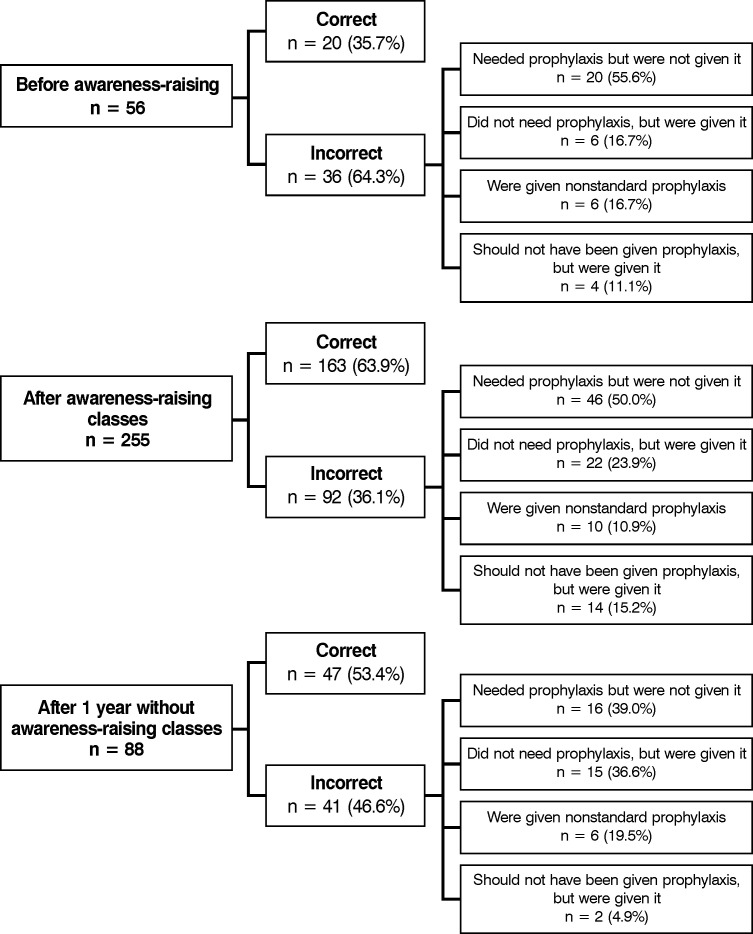
Pharmacological prophylaxis performance over the course of the study.